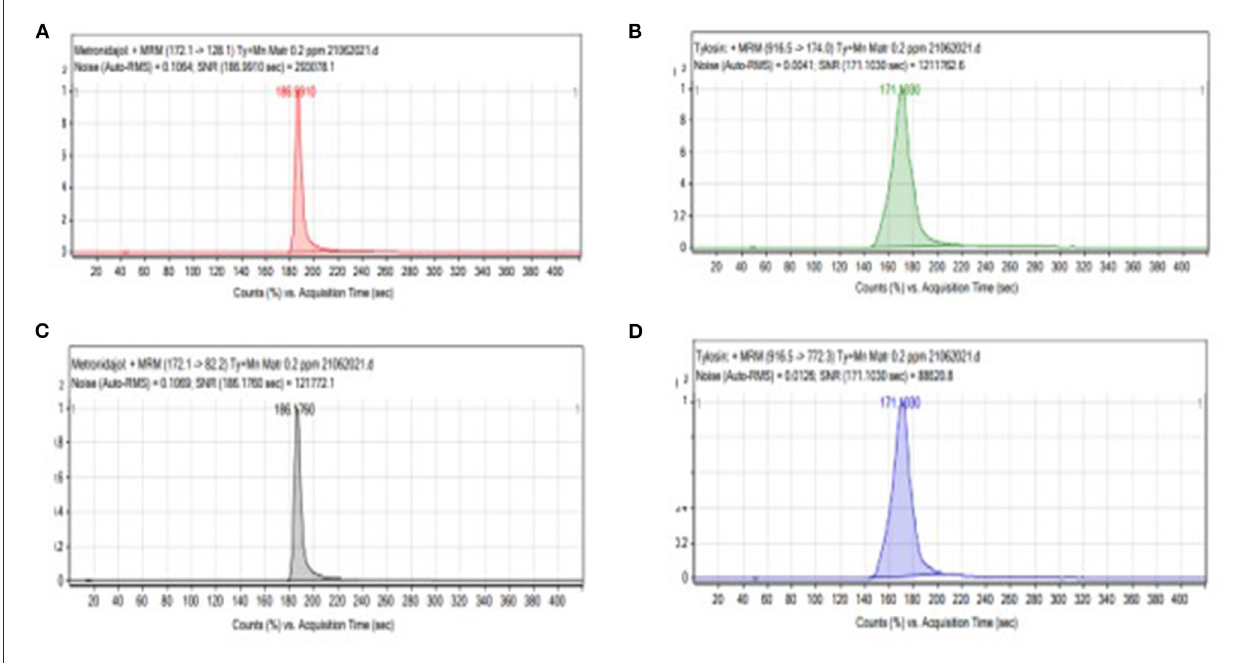
FIGURE2 (A, B) Tyl-spiked sample and (C, D) MNZ-spiked